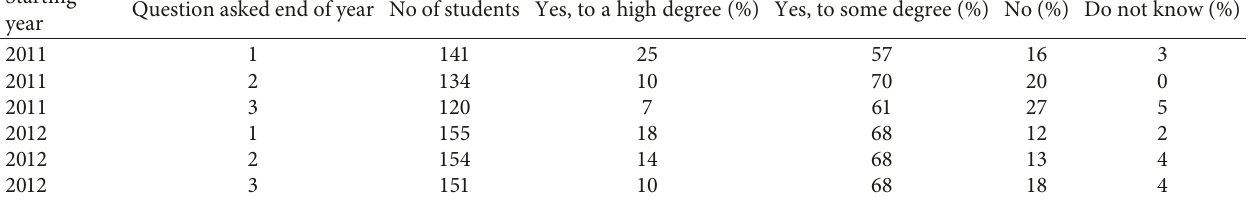
Table 8: Results from the question “Has PIC promoted you to analyze and adapt your study habits?” posed to the students at the end of each academic year. Starting